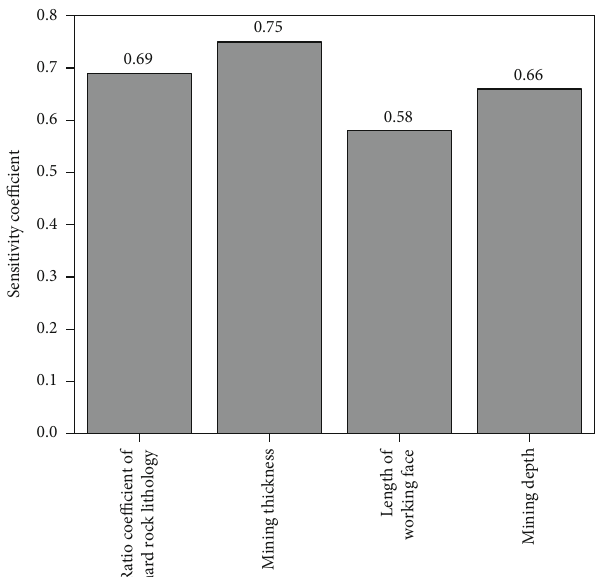
Figure 4: Sensitivity coe ffi cient of in fl uence factors.